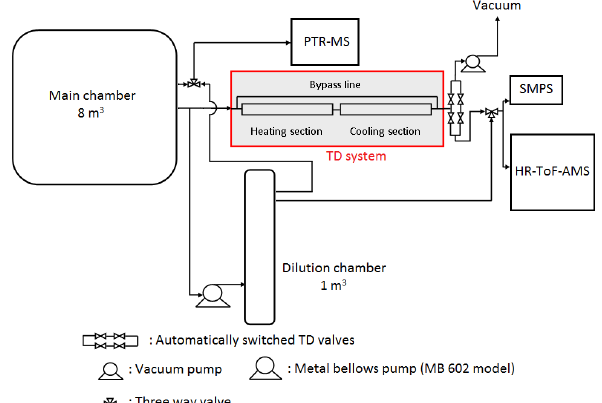
Figure 1. Schematic of the experimental setup used in the experi- ments. The COA in the main chamber was characterized using a TD a HR-ToF-AMS and an SMPS. A metal bellows pump was used to transfer OA from the main to the dilution chamber. The COA in the dilution chamber was measured by the HR-ToF-AMS and the SMPS. A PTR-MS was used to measure the dilution